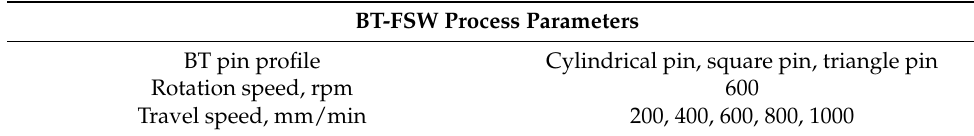
Table 3. BT-FSW process parameters of AA1050-H14 lap joints.